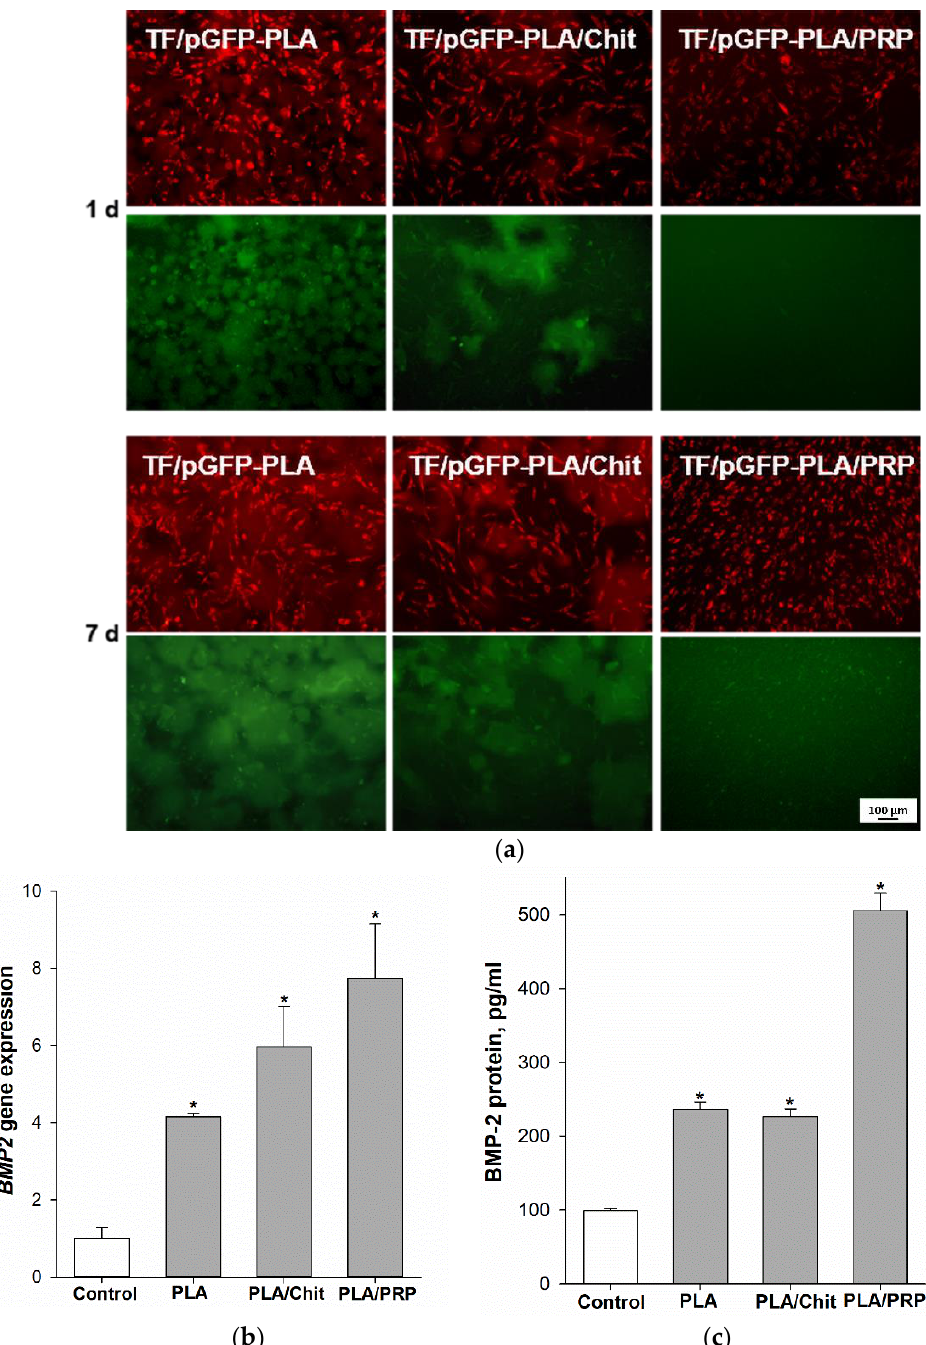
Figure 5. Transfecting ability of gene-activated matrices: ( a ) the ability of TF/pGFP-Matrices to transfect MSCs (green) prestained with PKH-26 (red), fluorescent microscopy; ( b ) relative BMP2 gene expression 14 days after incubation of MSCs with TF/pBMP2-Matrices, RT-PCR; and ( c ) BMP-2 protein production 14 days after incubation of MSCs with TF/pBMP2-Matrices, ELISA. * p < 0.05 (relative to control without matrices).